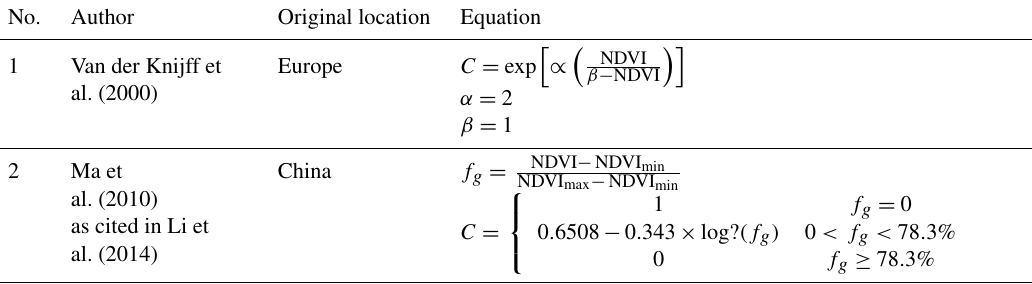
Table 7. C -factor equations that use NDVI.